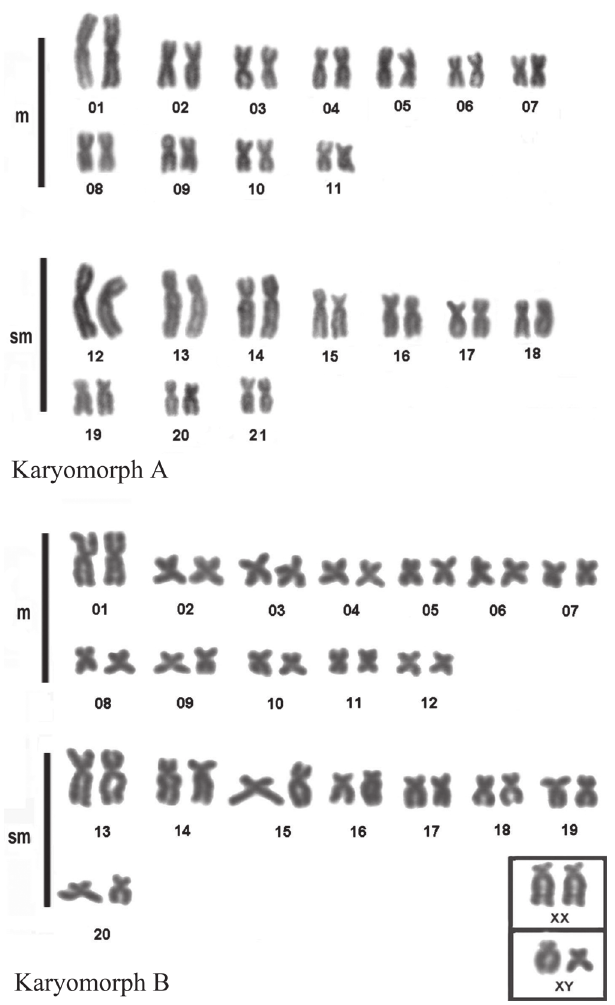
Fig. 2. Giemsa-stained H . malabaricus karyomorphs from middle rio Doce lakes, MG,